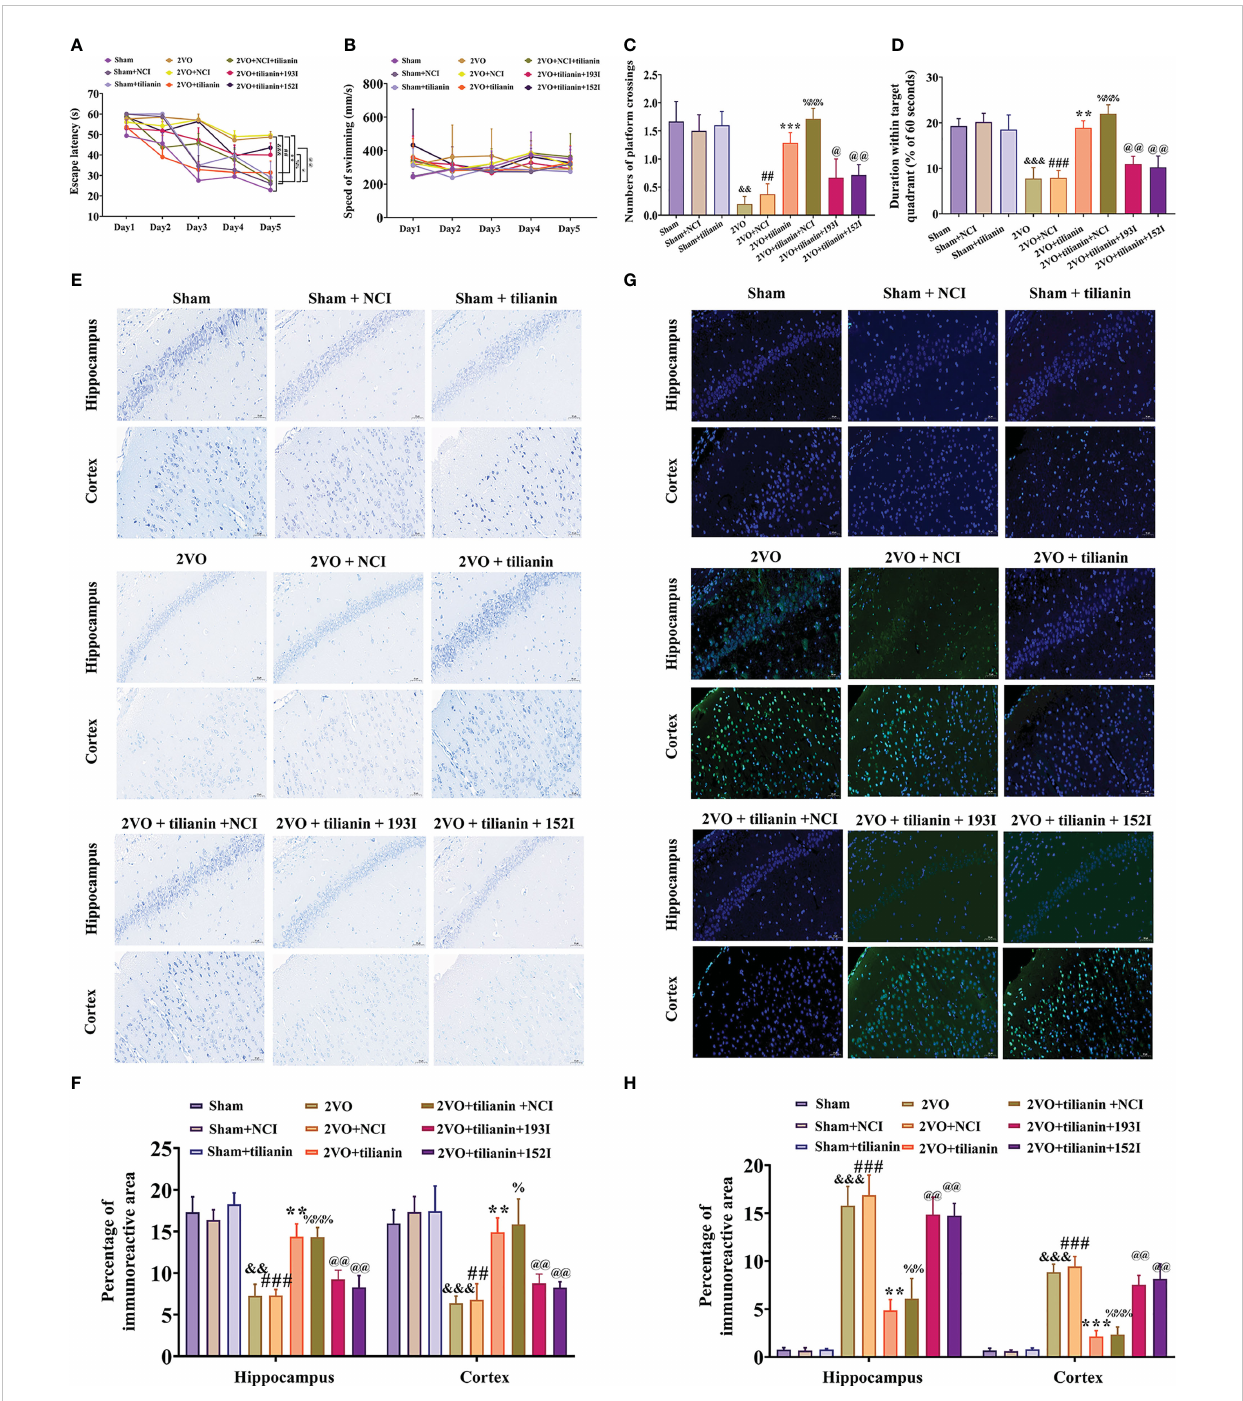
FIGURE 8 The ameliorative effects of tilianin on cognitive decline and neurodegeneration in VaD model rats were blocked by the miR-193b-3p or miR-152-3p inhibitor. (A) Escape latency in the Morris water maze navigation test ( n =8). (B) Swimming speed in the navigation test ( n =8). (C) Percentage of time spent in the target quadrant in the probe test ( n =8). (D) Number of crossings where the platform was previously located in the probe test ( n =8). (E) Representative images of Nissl-stained cortical and hippocampal neurons ( n =3). Scale bar=50 m m. (F) Quantitative analysis of immunoreactivity of Nissl staining in the cerebral cortex and hippocampus of 2VO rats ( n =3). (G) Representative images of TUNEL-stained cortical and hippocampal neurons ( n =3). Scale bar=50 m m. (H) Quantitative analysis of immunoreactivity of TUNEL staining in the cerebral cortex and hippocampus of 2VO rats ( n =3). Results represent the mean ± SD. && P <0.01, &&& P <0.001 vs. sham group, ## P <0.01, ### P <0.001 vs. sham+NCI, ** P <0.01, *** P <0.001 vs. 2VO, % P <0.05, %% P <0.01, %%% P <0.001 vs. 2VO+NCI, @ P <0.05, P <0.01 vs.